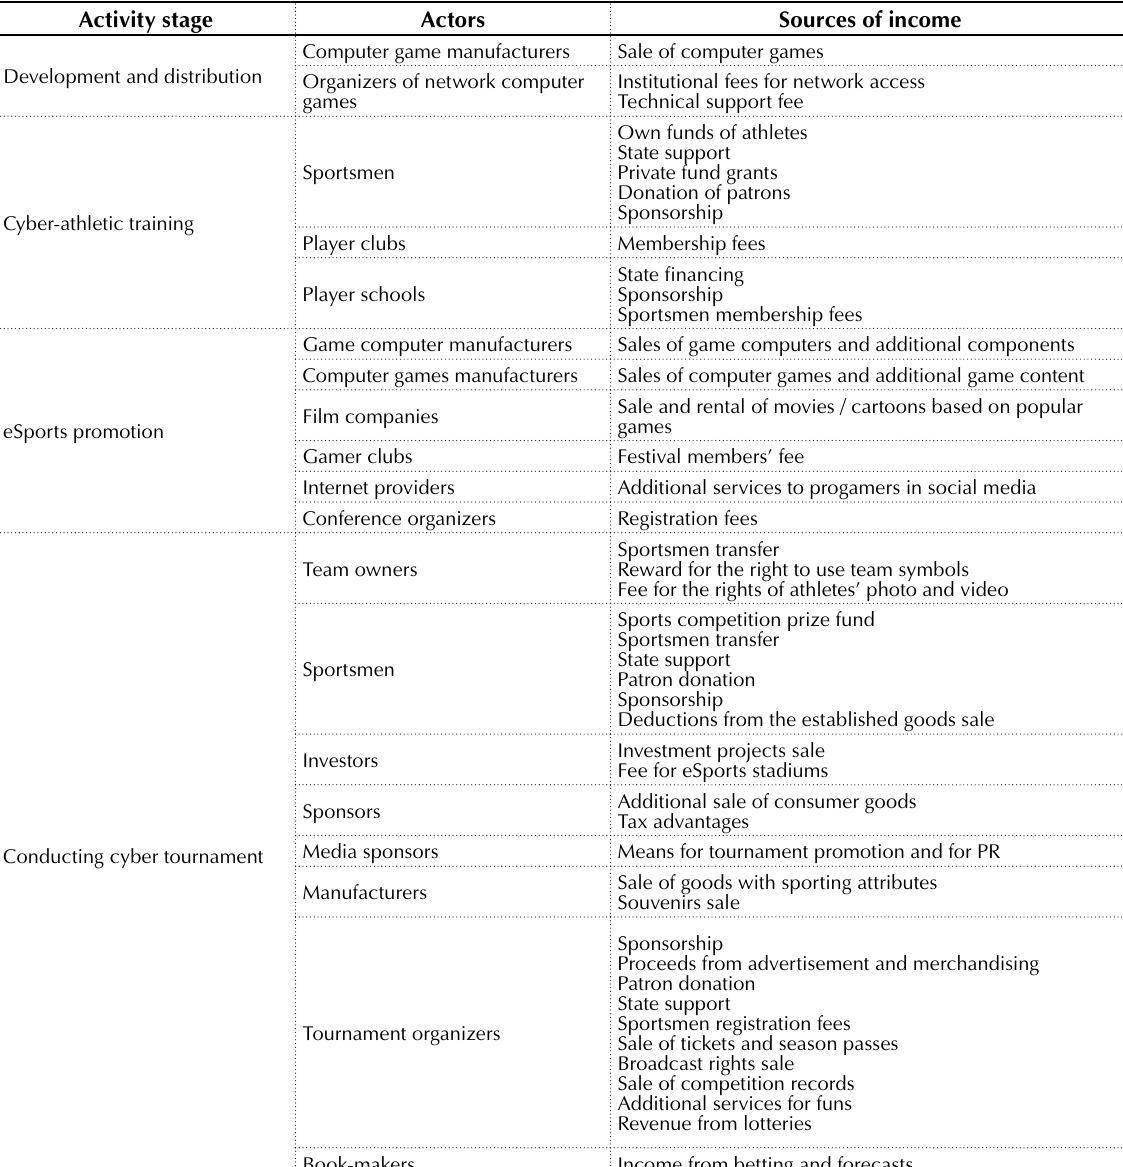
Source: Compiled by